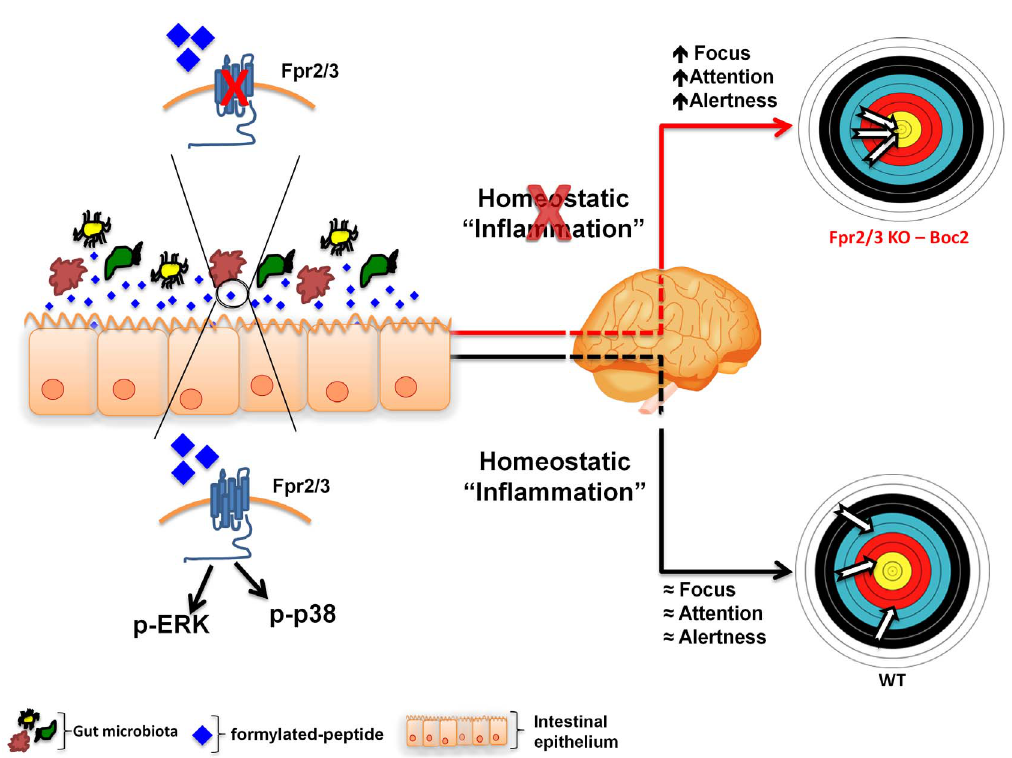
Fig. 10. Hypothetical schema of the role of Fpr2/3 at the interface of the gut-brain axis. Non-pathogenic gut microbiota releases physiological levels of formylated peptides that activate FPR signalling in the gut epithelium. This homeostatic level of protective inflammation influences brain function maintaining a physiological level of focus and attention. The blockage of FPR signalling by an antagonist or the absence of gut microbiota causes a reduction in FPR activation and a parallel increase in the state of alertness, as observed in Fpr2/3 -/- and Boc2-treated